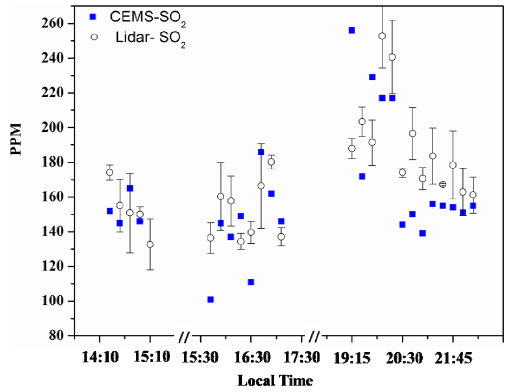
Figure 10. Comparison of SO 2 concentrations simultaneously measured from the DIAL and in situ instruments (CEMS) on 29 July 2010 over the Guanyin industrial area. Error bars indicate the statistical SO 2 concentration uncertainty derived from the DIAL measurements.